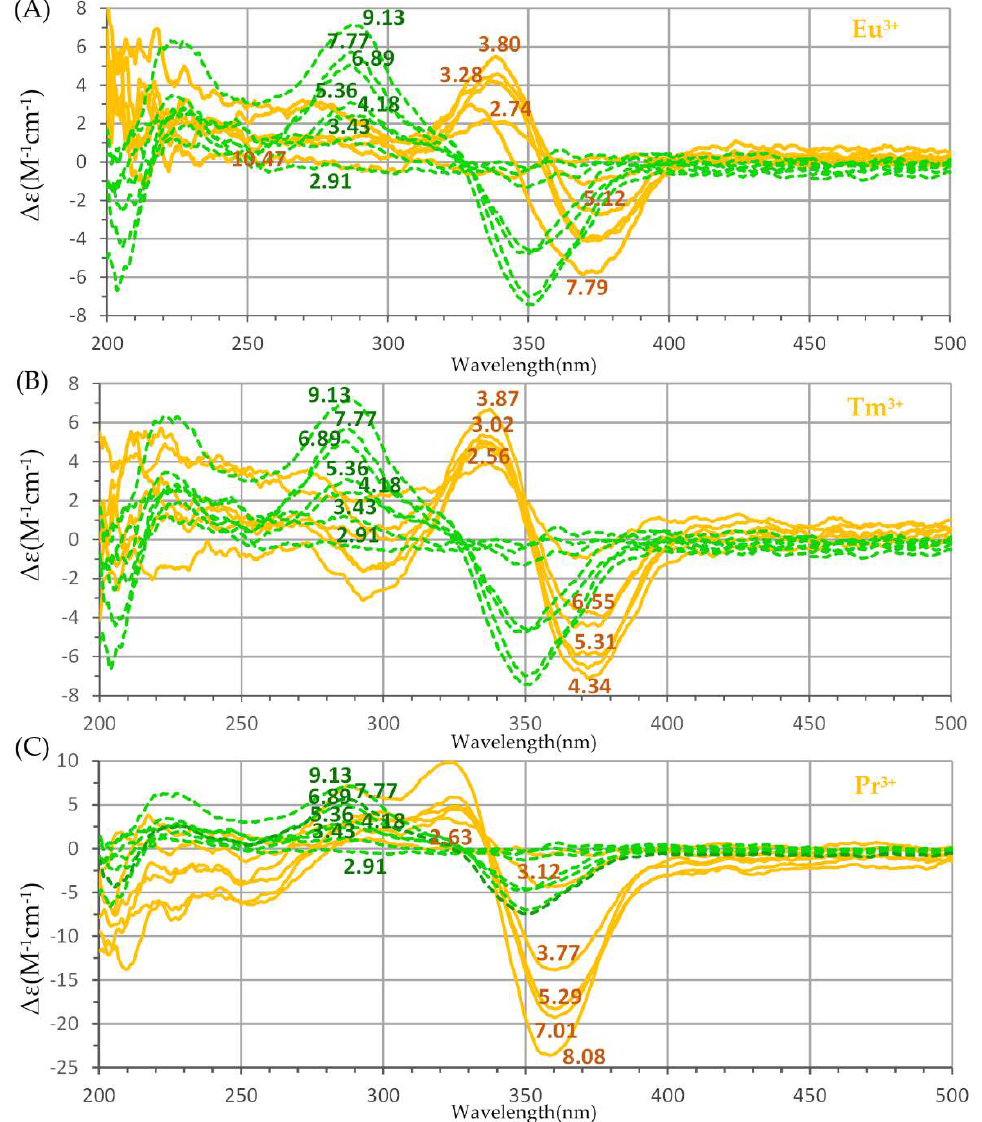
Figure 2. ( A ) Superimposition of Far–UV circular dichroism (CD) spectra of harzianic acid ( ≤ 1.72 × 10 −4 M) at different pH (green dashed curves) and of CD spectra at different pH of: (A) Eu 3+ -harzianic acid system at 1.044: 1 ligand-to-metal ratio (full orange curves); ( B ) Tm 3+ -harzianic acid system at 1.037: 1 ligand-to-metal ratio (full orange curves); ( C ) Pr 3+ -harzianic acid system at 1.978: 1 ligand-to-metal ratio (full orange curves). All spectra have been acquired in a 0.1 M NaClO 4 /(CH 3 OH + H 2 O 50/50 w / w ) solvent. Numerical labels on curves indicate the corresponding pH and may serve as a link to connect each spectrum to solutions in Table 2.